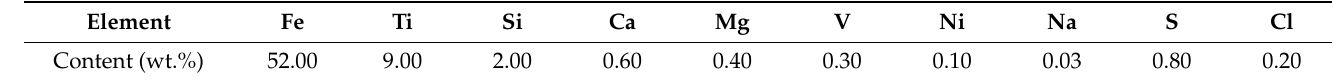
Table 1. Chemical compositions (ICP) of vanadium magnetite concentrate. Element